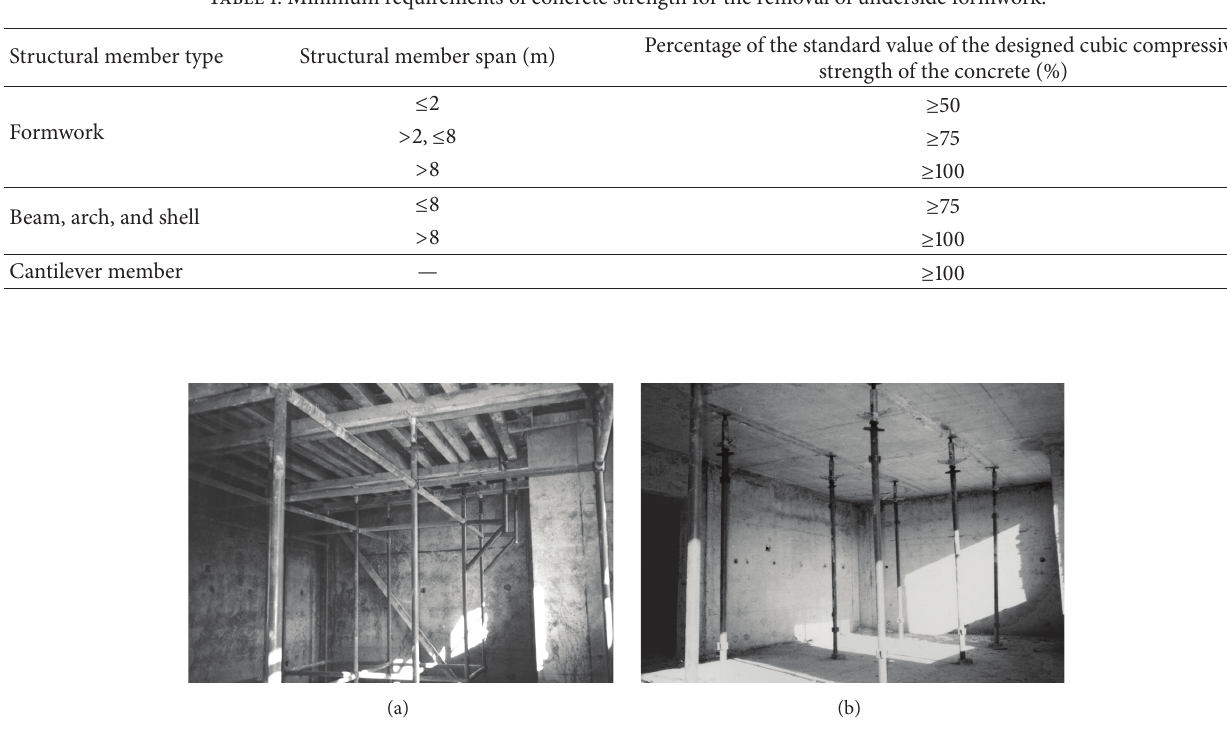
Figure 1: The comparison of vertical formwork supporting system. (a) shows the complete erection of formwork. (b) shows the concrete floor